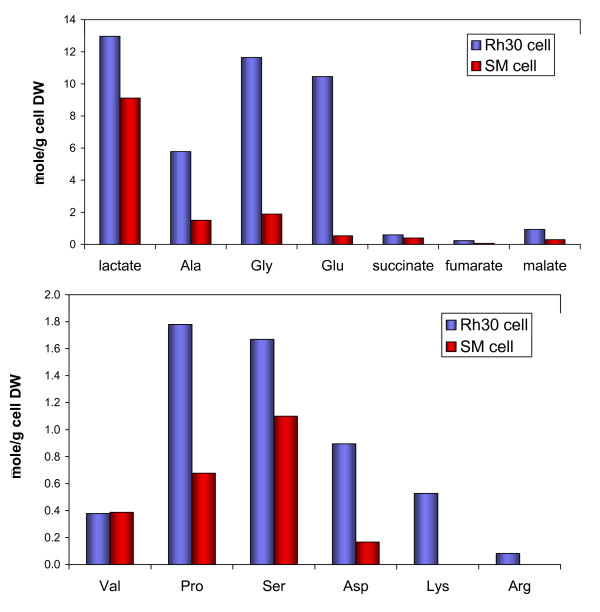
Concentration of metabolites in cell extracts of Rh30 cells and myocytes. Concentrations were determined by GC-MS as described in the text. A, B: Total concentrations of selected metabolites normalized to cell dry weight.